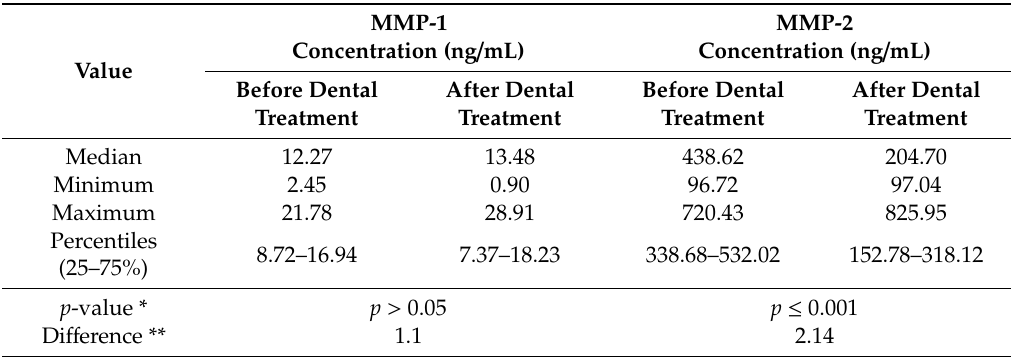
Table 2. The statistical parameters of fibronectin concentrations in saliva before and after dental treatment. Fibronectin Concentration [ µ g / mL] Value Before Dental Treatment After Dental Treatment Median 9.97 11.43 Minimum 1.27 Maximum